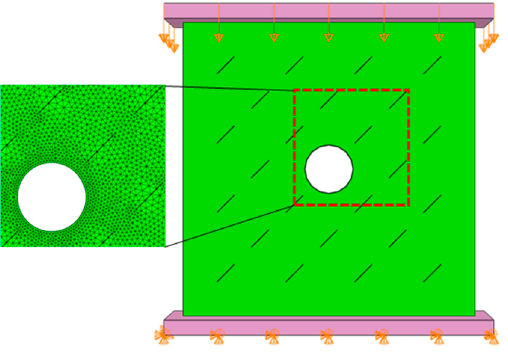
Figure 15. The FE model of specimen HC45 and the location of the five selected elements. Table 4. Material parameters of the MPD model used in numerical modeling.